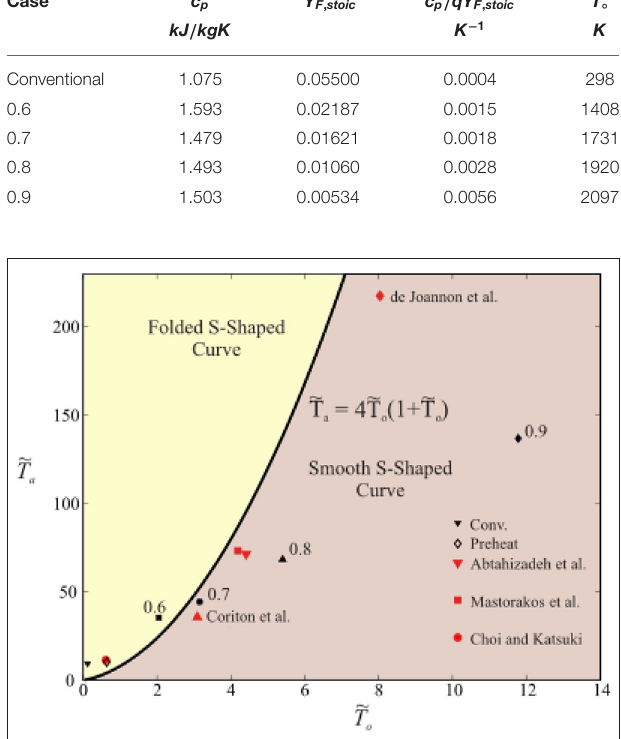
FIGURE 3 | A plot of the function defining the requirement for the existence of critical points or a folded S-Shaped Curve in a CH 4 combustion system, Equation (20), and points from CH 4 /hot product simulations presented in Sidey et al. (2014) and highly diluted cases from Coriton et al. (2010), Abtahizadeh et al. (2012), Mastorakos et al. (1995), Choi and Katsuki (2002), and de Joannon et al.